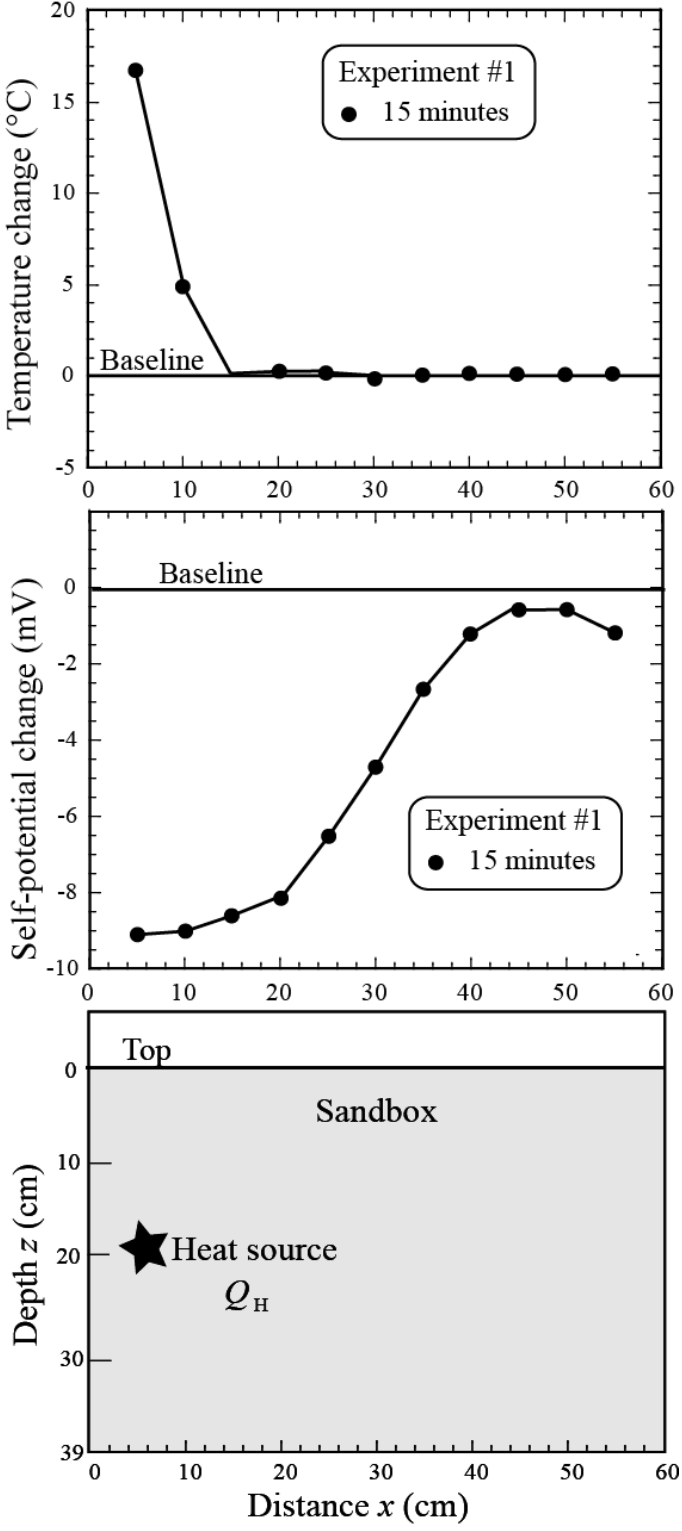
Figure 11. Distribution of temperature (at a depth of 20 cm), self-potential (at the top of the tank) at a given time after the introduction of the heat source Q a sandbox. We have removed the temperature and self-potential distributions recorded prior the introduction of the heat source (modified after